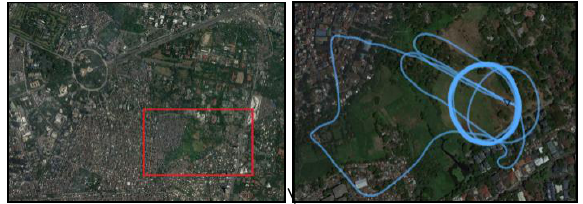
Figure 1. The project site: Hardin ng Rosas, an urban area in UP Diliman Campus of Quezon City, Metro Manila. (Flight path is represented by the blue lines) (Source: Google Earth Images)